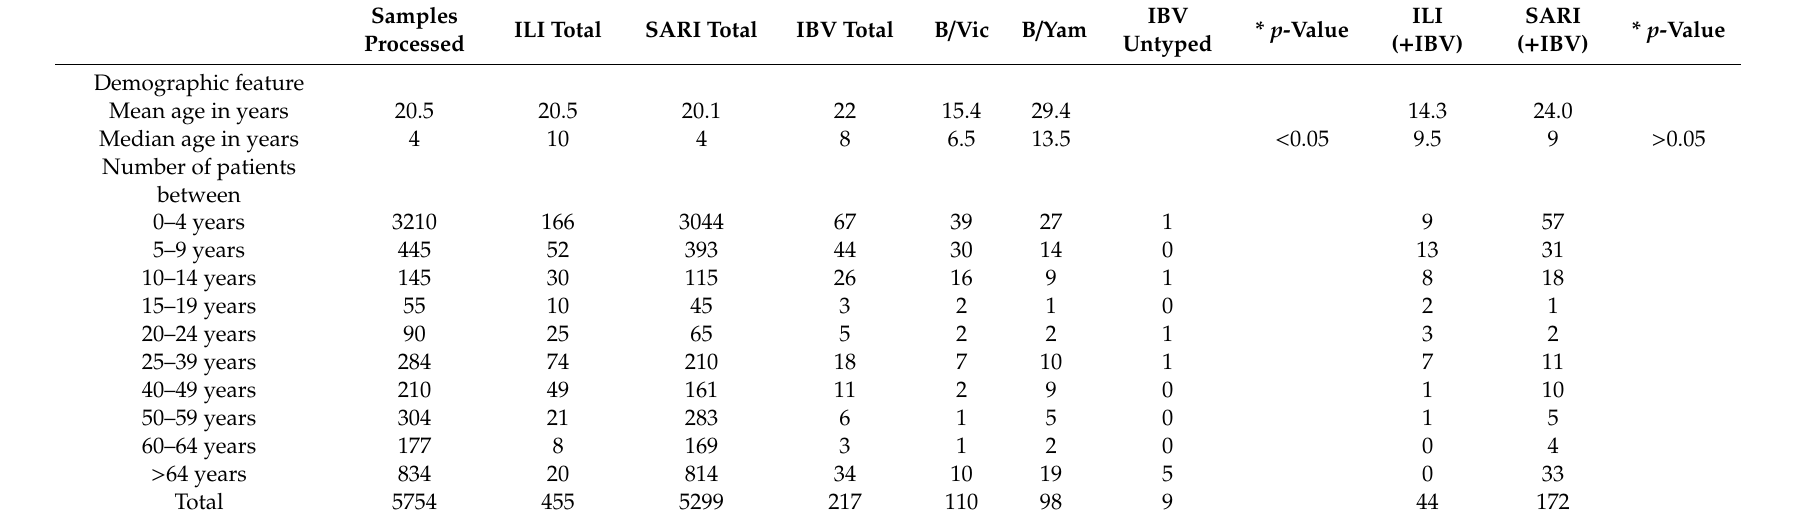
Table 1. Age distribution of influenza B infections according to type of surveillance and influenza B lineages. Numbers of patients are indicated according to age group, discriminating by type of surveillance and influenza B lineages between 2012–2019. Lineage determination in samples n = 208. * p -value was calculated while using the Pearson chi-square test and the median